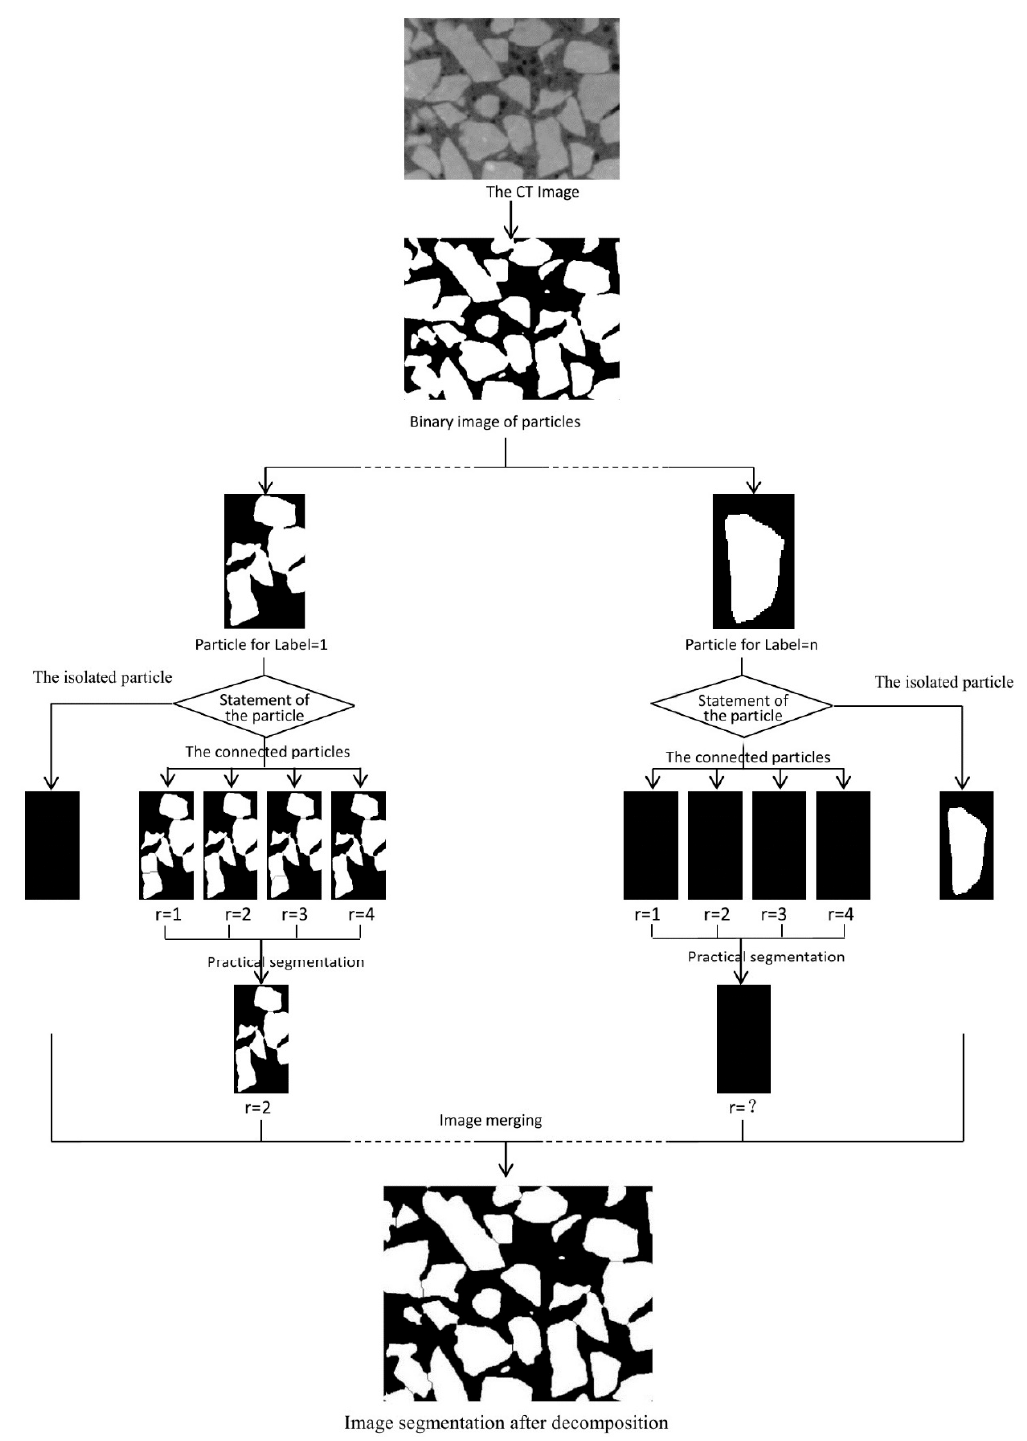
Figure 1. The morphological multiscale algorithm flow chart for adhesion aggregate segmentation.